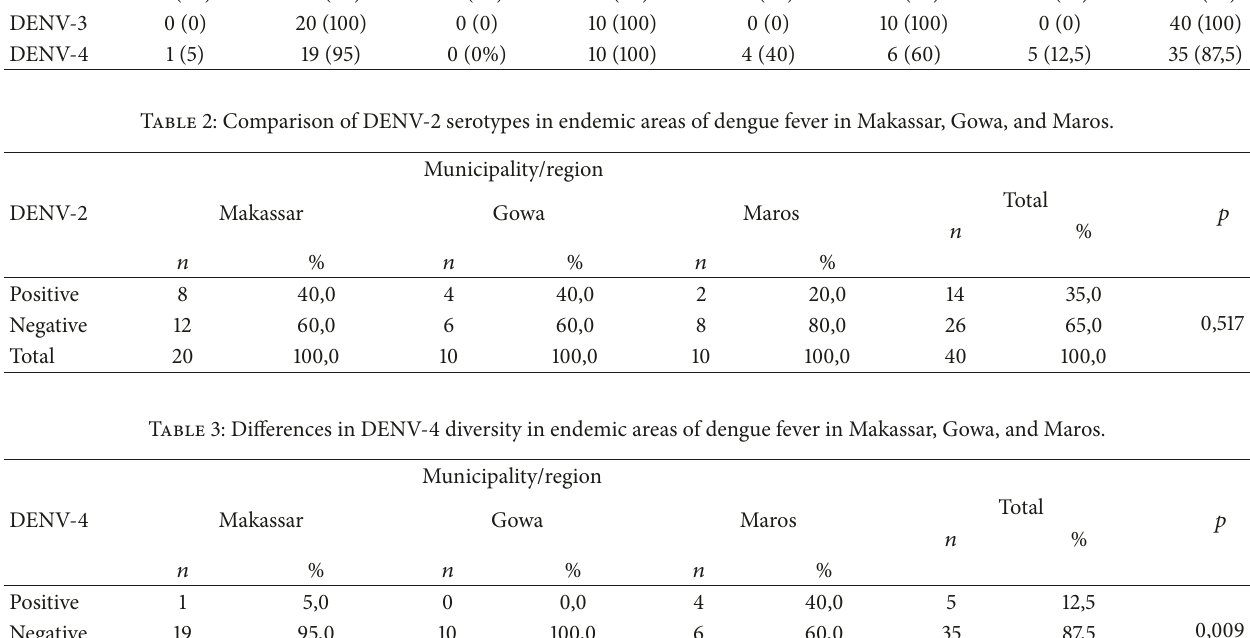
Table 1: Distribution of DENV virus serotype in Makassar, Gowa, and Maros. Region Serotype